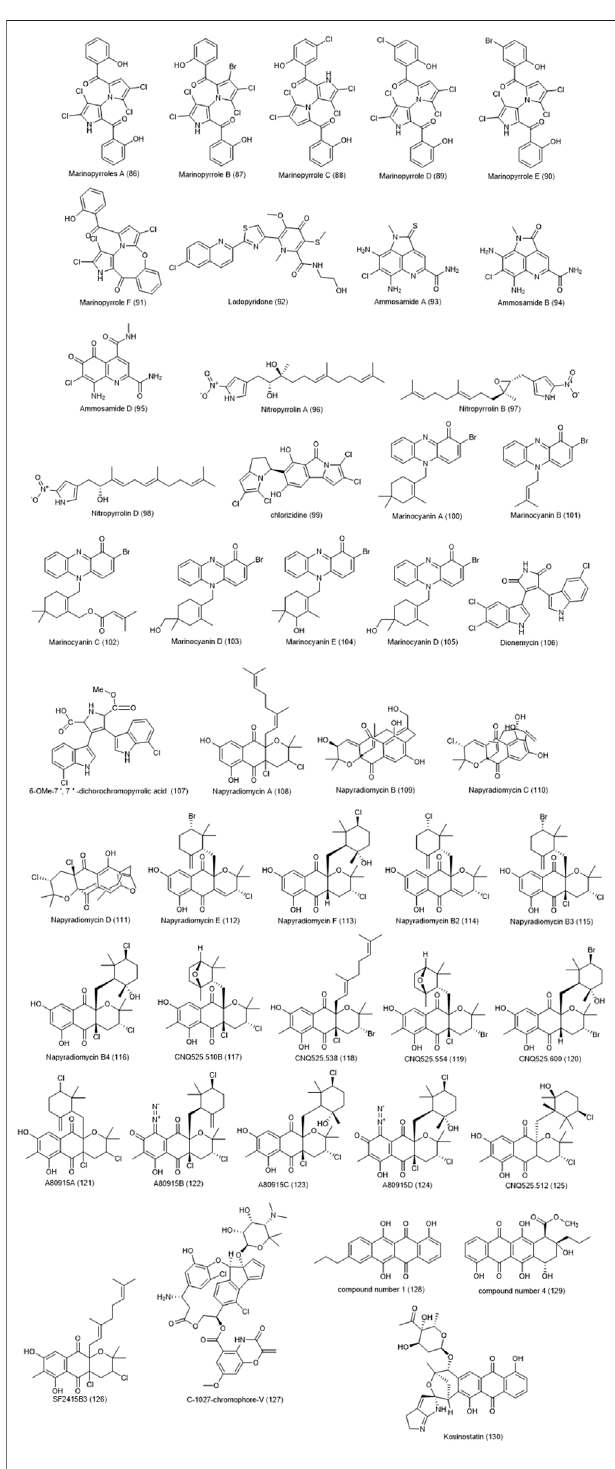
FIGURE 4 | Chemical structures of NPs 86 –